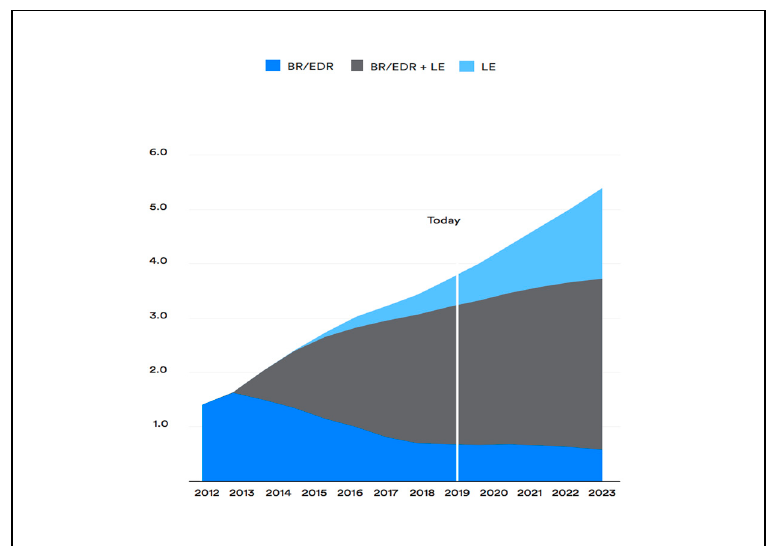
Figure 2. Bluetooth device shipments by the radio version (in billions) [2] .